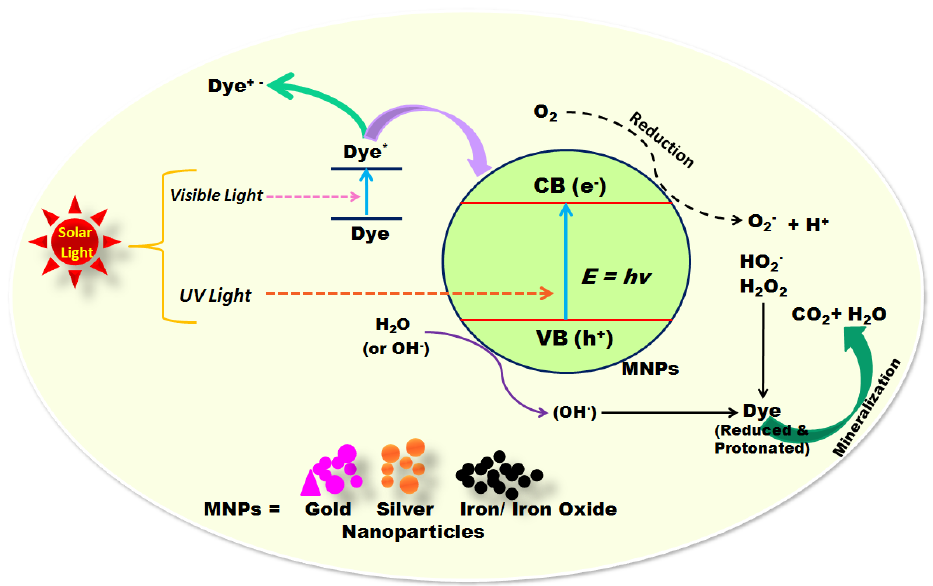
Figure 7. General mechanism for the photocatalytic degradation of different dyes using various nanoparticles of gold, silver and iron/iron oxide. nanoparticles of gold, silver and iron/iron